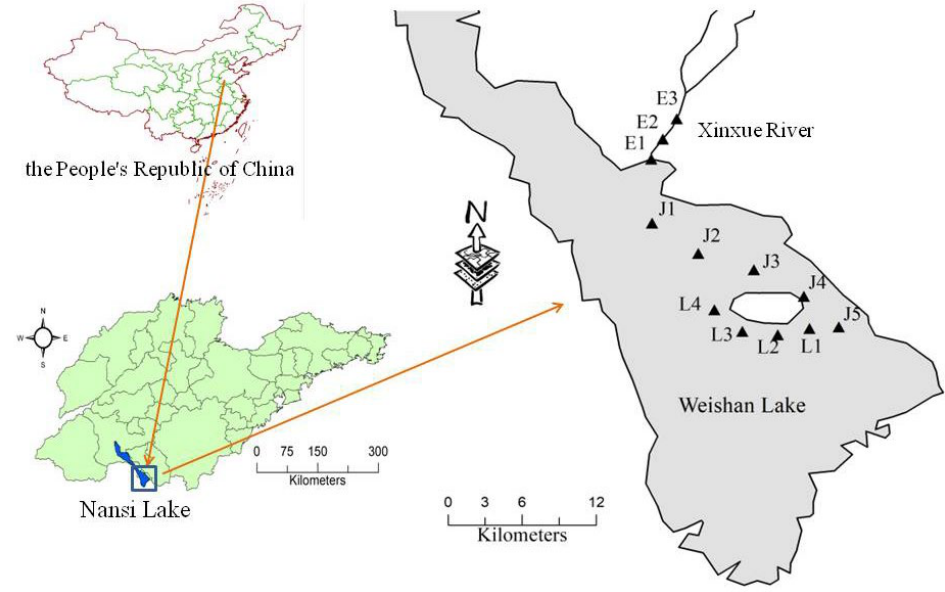
Figure 1. Location of the sampling sites in the Weishan Lake basin.